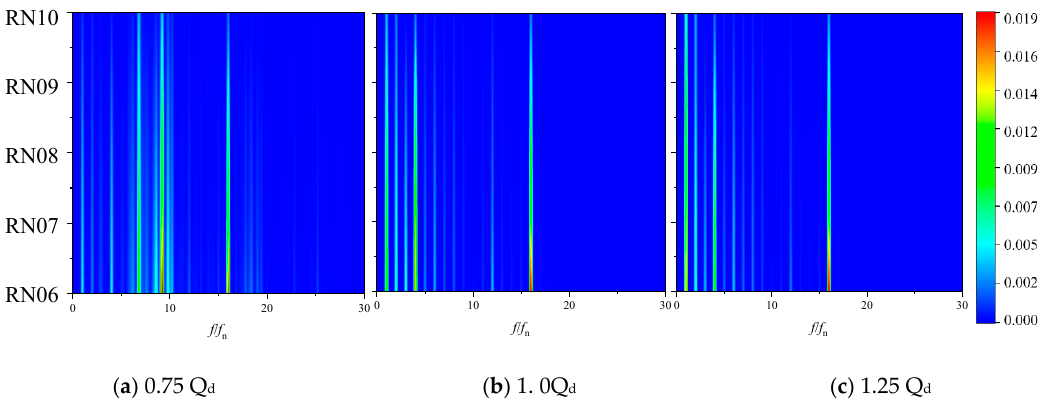
Figure 11. Frequency domain of pressure fluctuation near the pressure side of the short blade.